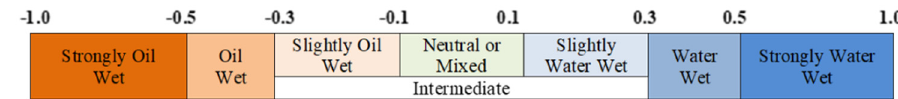
Figure 2. Categorization of rock wettability based on the wettability index.